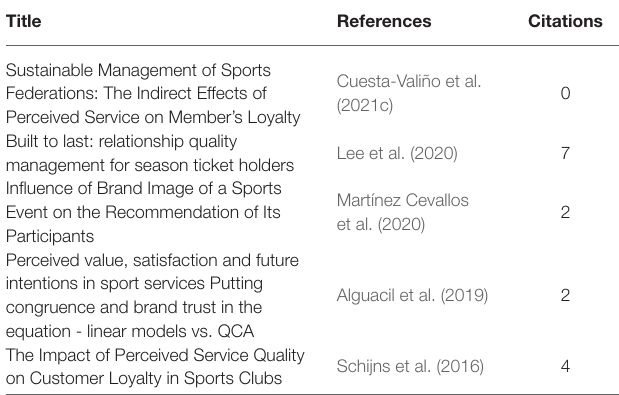
TABLE 8 | Articles that include all analyzed